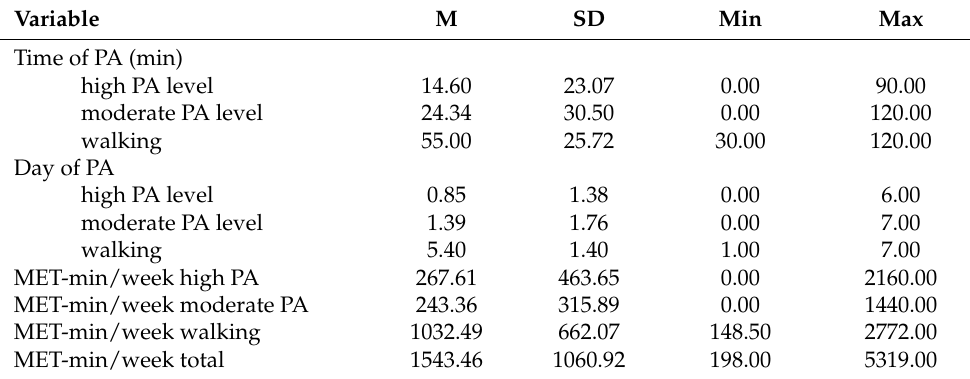
Table 3. Characteristic of physical activity according to